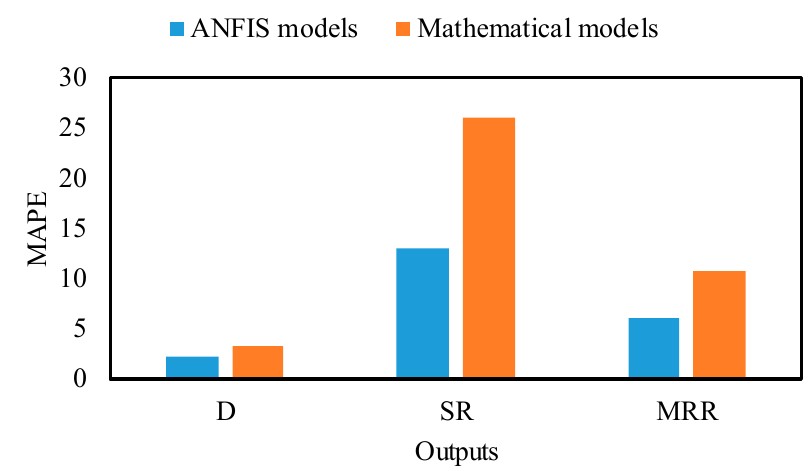
Figure 13. Comparison of the developed models.